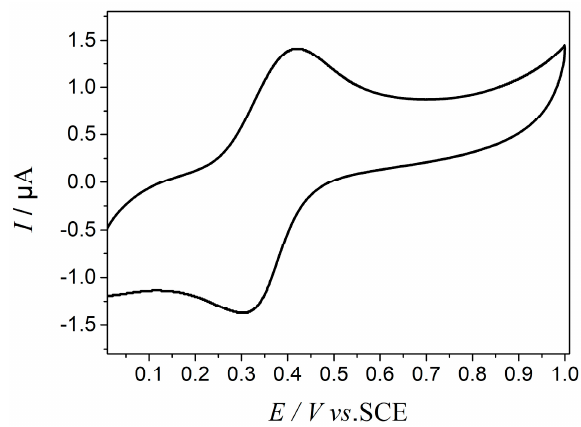
Figure 7. Cyclic voltammogram of FcA in 0.1 mol L − 1 KCl solution at a scan rate of 50 mV s − 1 .